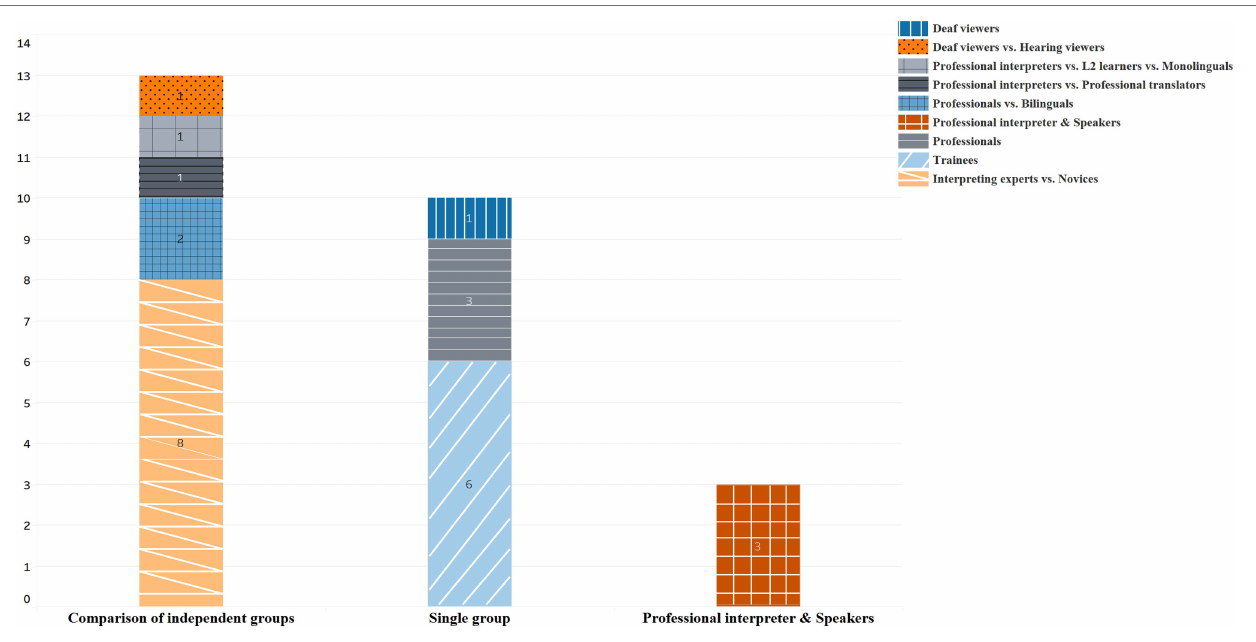
FIGURE 3 | Number of papers for each type of participants